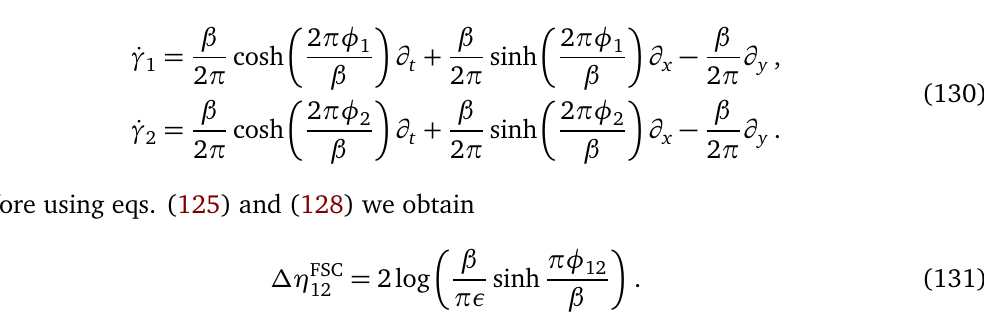
on each of the black points on i (cid:12) ∝ ∂ (cid:12) . Figure i r (cid:12) γ i